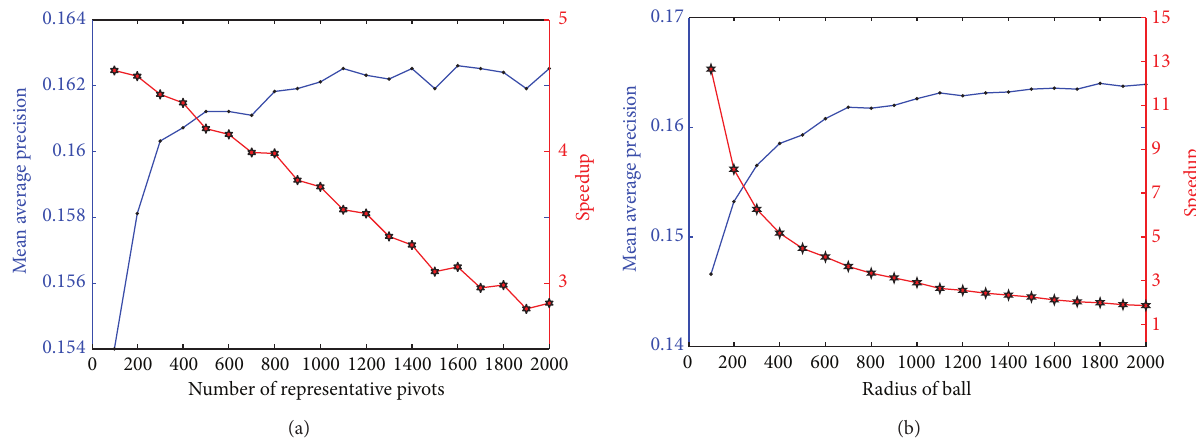
Figure 6: Performance evaluation on Corel 10 K for a number of representative pivots and radius of ball. (a) MAP variations with the number of representative pivots. (b) MAP variations with radius of ball.